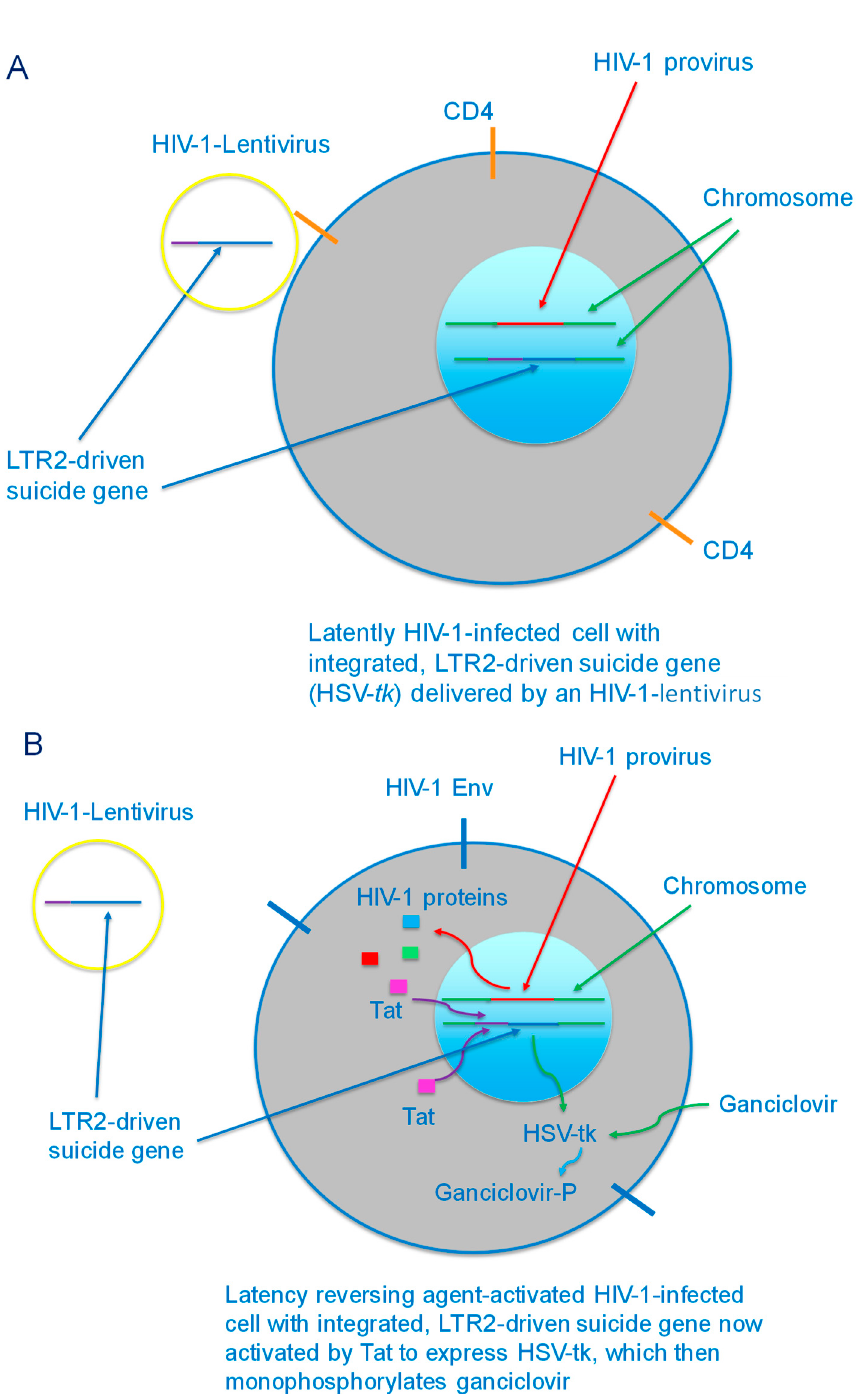
Figure 2. Comparison of luciferase gene expression from wild type LTR and LTR mutant clones (shown in Figure 1) in HeLa cells and HeLa-tat-III cells that constitutively express the HIV-1 Tat protein (data from [39]).